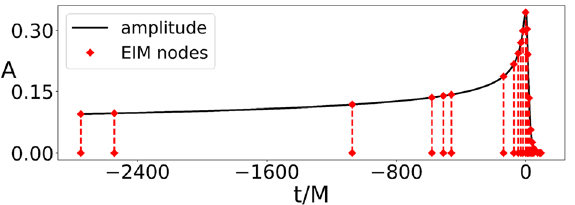
Figure 1. Amplitude for the surrogate waveform q = 2 ; the red diamonds denote the EIM time nodes, which are by construction the same for all q ∈ [ 1, 10 ] . Their adaptive nature, leading to a resolution improvement around the peak of the amplitude, can be